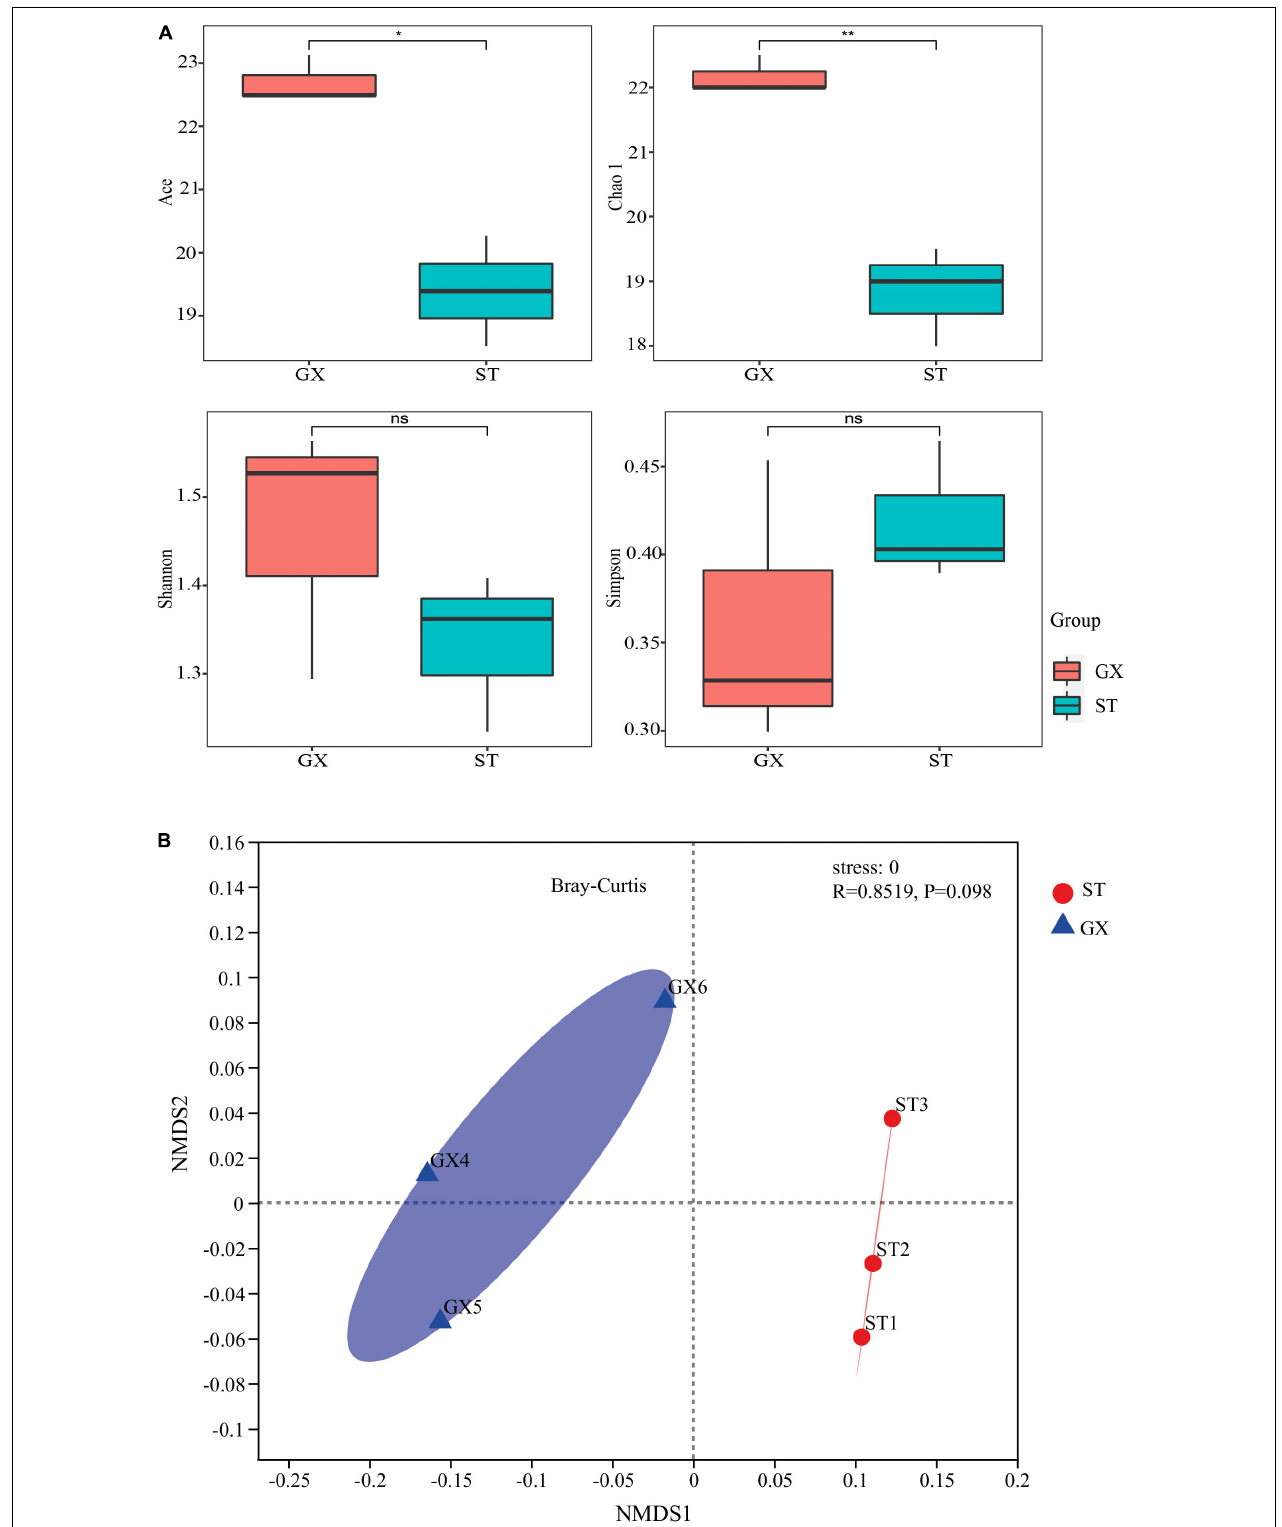
FIGURE 1 | The diversity of bacterial communities associated with Phaeocystis globosa GX and ST strain cultures. (A) α -Diversity indices for the two co-culture communities. Statistical differences between pairs were assessed by t -tests. ns Not significant; * p < 0.05; ** p < 0.01. (B) Non-parametric multidimensional scaling (NMDS) plots show variation in OTU compositions among the two co-cultures. GX, P . globosa GX strain co-culture; ST, P . globosa ST strain co-culture.